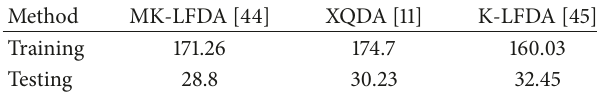
Figure 4: Performance at rank@1 when centers 𝑚 𝑘 are selected ran- domly, and when centers are selected with our approach provided in Section 2.2. Table 5: Run time comparison on CUHK03 (in